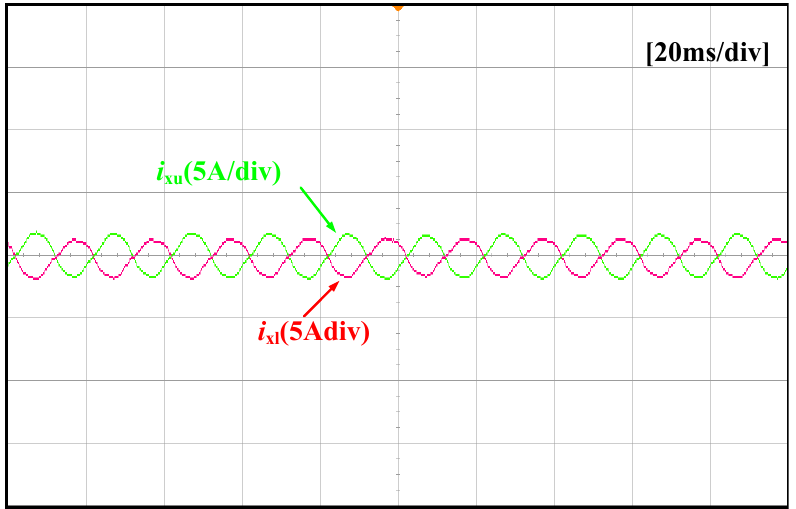
Figure 33. Experimental results of the arm currents.